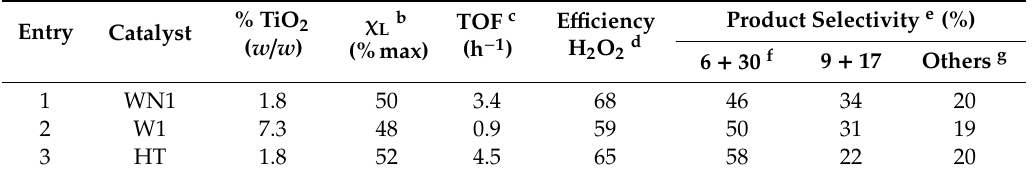
Table 9. Oxidation of limonene with titanium-MCM-41 catalysts a (adapted from reference [42]). Product Selectivity e (%) % TiO 2 E ffi ciency TOF c χ L b Entry Catalyst ( w / w ) H 2 O 2 d (h − 1 ) (%max) 6 + 30 f 9 + 17 Others g 1 WN1 1.8 50 3.4 68 46 34 20 2 W1 7.3 48 0.9 59 50 31 19 3 HT 1.8 52 4.5 65 58 22